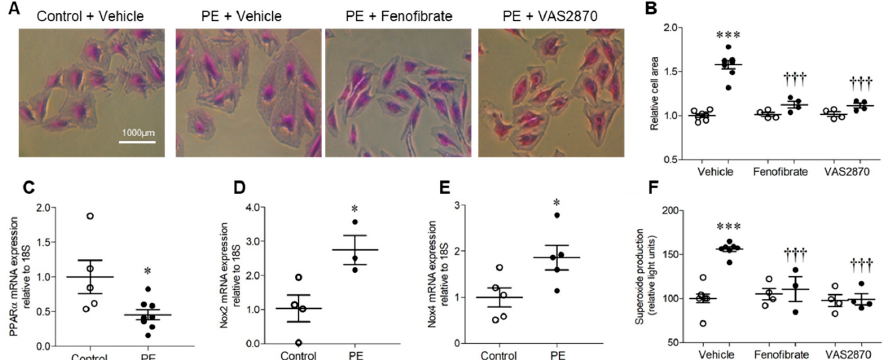
Figure 1. H9c2 cardiomyoblast hypertrophy and associated NADPH oxidase-dependent superoxide production are inhibited by PPAR α activation. ( A , B ) H9c2 cells stimulated with phenylephrine (PE) display hypertrophy as indicated by increased cell area, which is prevented by PPAR α activation (fenofibrate, 10 µ mol / L) and NADPH oxidase inhibition (VAS2870, 10 µ mol / L). Representative images (10 × magnification) are shown in ( A ) and mean data in ( B ). ( C ) PE induces downregulation of PPAR α mRNA and upregulation of ( D ) Nox2 and ( E ) Nox4 mRNA expression. ( F ) PE stimulation is associated with elevated NADPH-dependent superoxide production with is abolished by PPAR α activation or NADPH oxidase inhibition. Mean ± SEM; N = 3–8; * p < 0.05, *** p < 0.001 vs. control, ††† and p < 0.001 vs. PE alone.